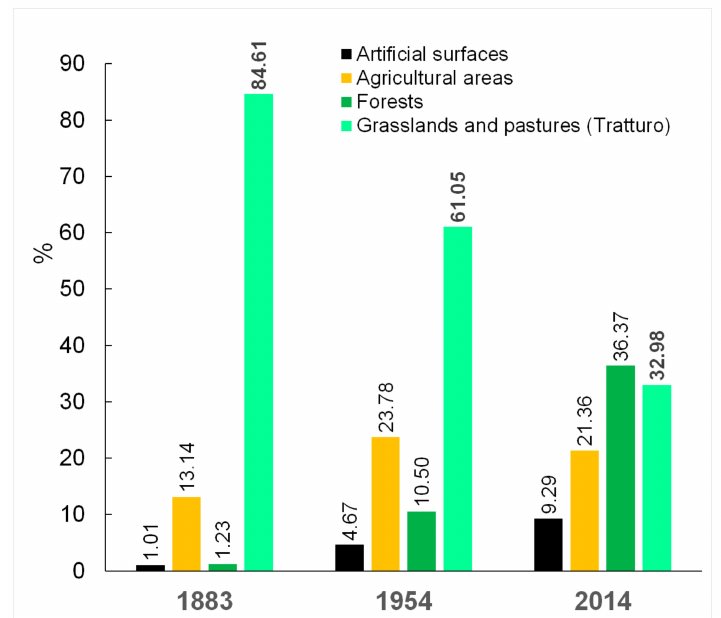
Figure 6. Percentage of land use squatting classes concerning the entire tratturo in the Bonamici’s reinstatement (1883) and in the maps made for 1954 and